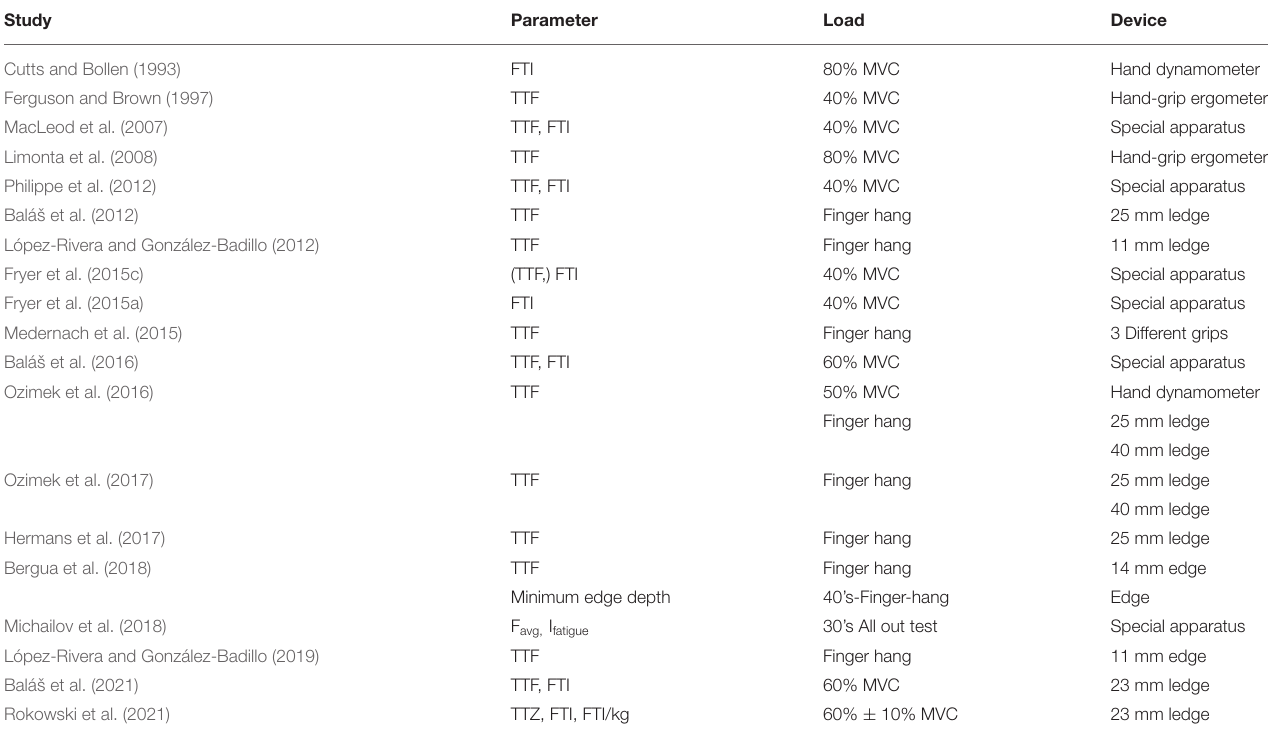
TABLE 1 | Overview of measurement methods of finger flexor muscle endurance based on sustained isometric